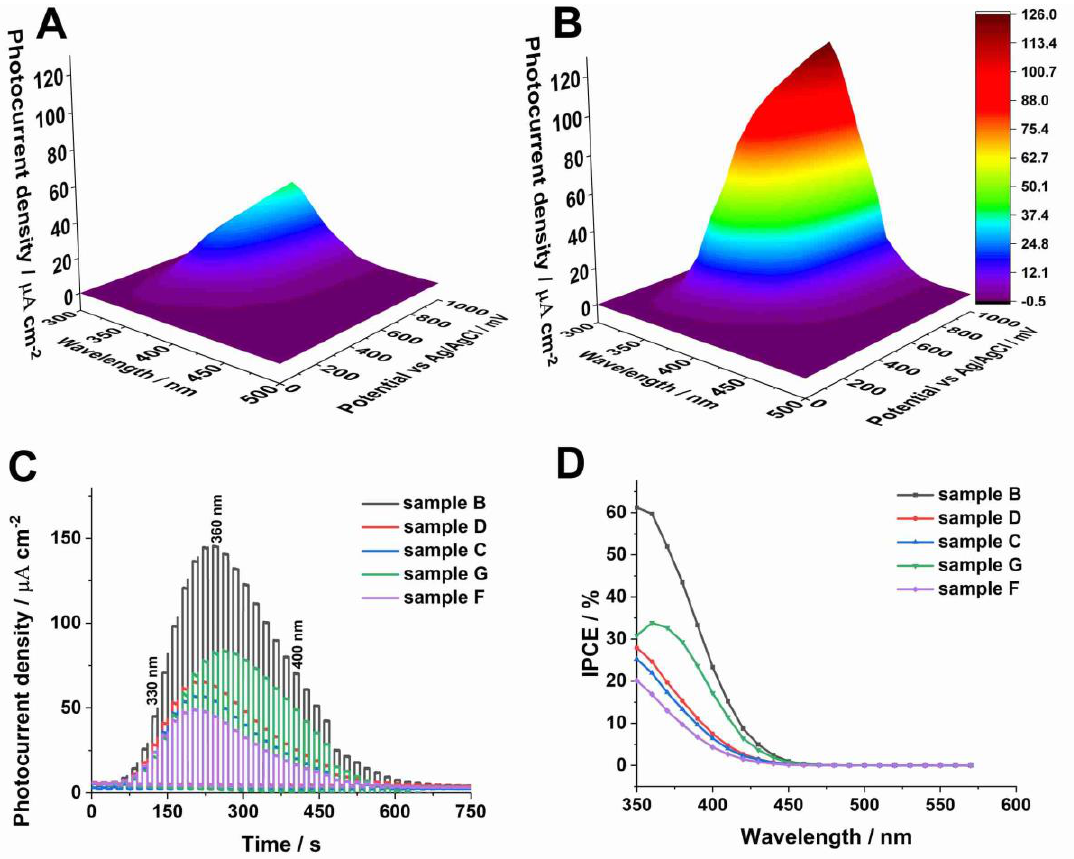
Figure 7. Photocurrent density as a function of the incident light wavelength and applied potential recorded in 0.1 M KNO 3 for the anodized and annealed sample F ( A ) and B ( B ). The photoelectrochemical response of all studied WO 3 samples at 1 V vs. Ag/AgCl ( C ) and corresponding IPCE spectra ( D ).